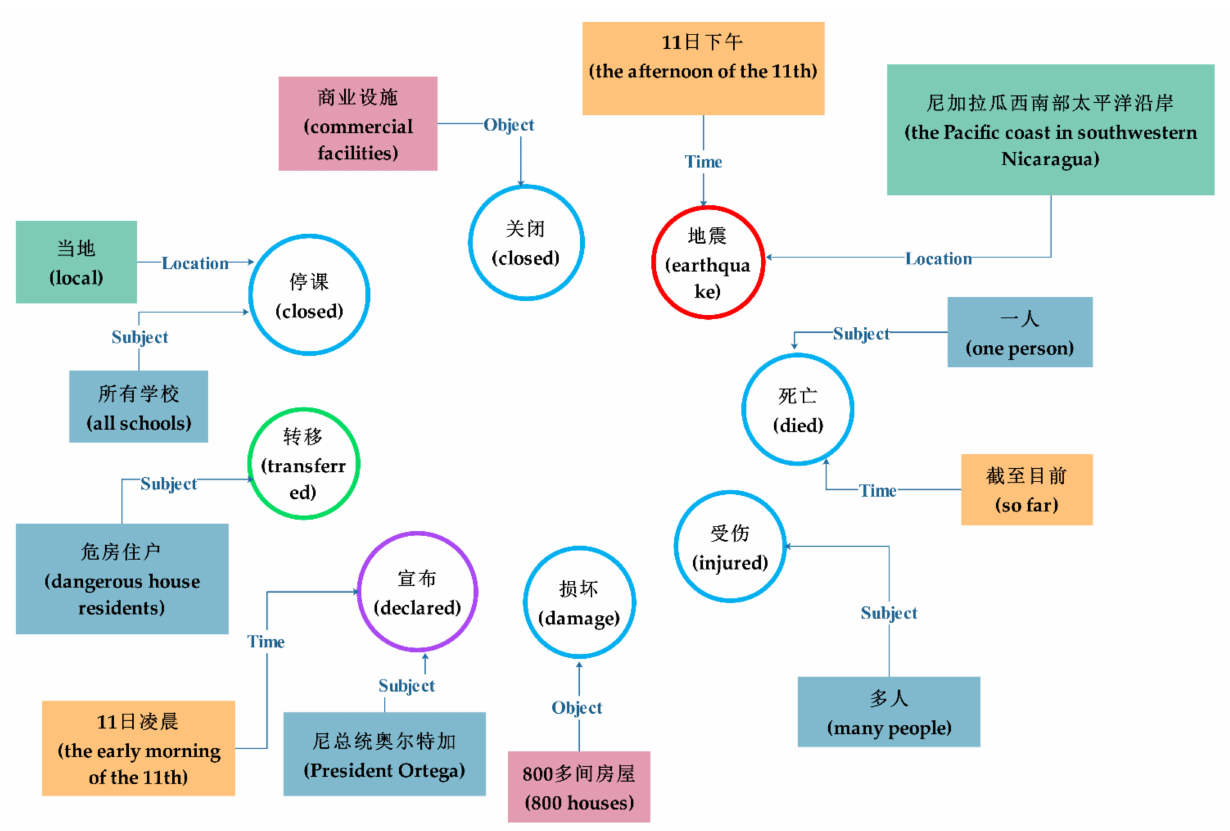
Figure 8. An example of event extraction results of